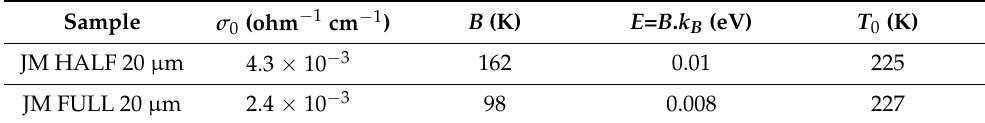
Table 1. VTF best-fit parameters of the data reported in Figure 3c. k B is the Boltzmann constant. Sample